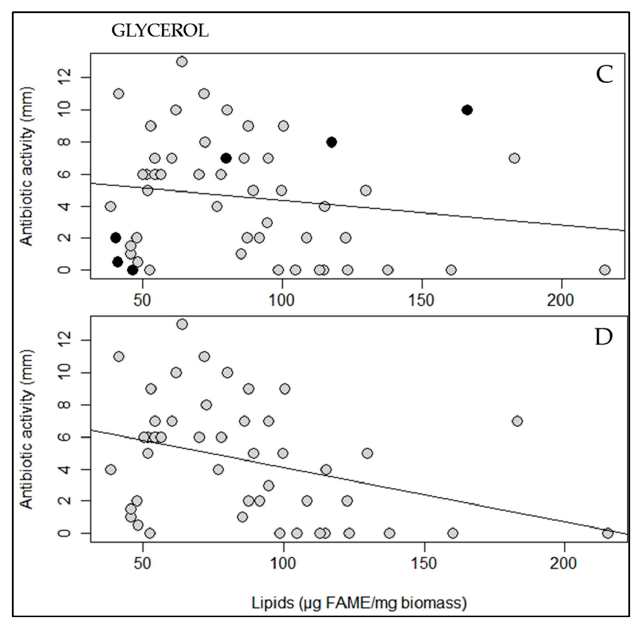
Figure 4. Lipid/FAME content of fifty-four Streptomyces strains grown on modified solid R2YE limited in phosphate for 72 h at 28 °C with ( A ) 50 mM glucose or ( C ) 100 mM glycerol as the main carbon source was plotted against their antibiotic activity, and linear regression lines were calculated (black lines). In ( A ) and ( C ), FAME content and antibiotic activity did not show a statistically significant negative Pearson correlation (coefficients of − 0.206 and − 0.167, p -values of 0.135 and 0.227 (> 0.05), on glucose and glycerol, respectively). In an attempt to enhance the amplitude of this negative correlation, six strains constituting exceptions (black spots) were removed. These strains were chosen as described in the text, and the vertical and horizontal dashed lines represent the quartiles (Q1, Q2 and Q3) of lipid content and antibiotic activity, respectively. The lipid/FAME content of the forty-eight remaining strains grown in the presence of ( B ) 50 mM glucose or ( D ) 100 mM glycerol was plotted against their antibiotic activity, and linear regression lines were calculated (black lines). In ( B ) and ( D ), the FAME content and the antibiotic activity show a statistically significant negative Pearson correlation (coefficients of − 0.432 and − 0.355, p -values of 0.002 and 0.013 (< 0.05), on glucose and glycerol, respectively).